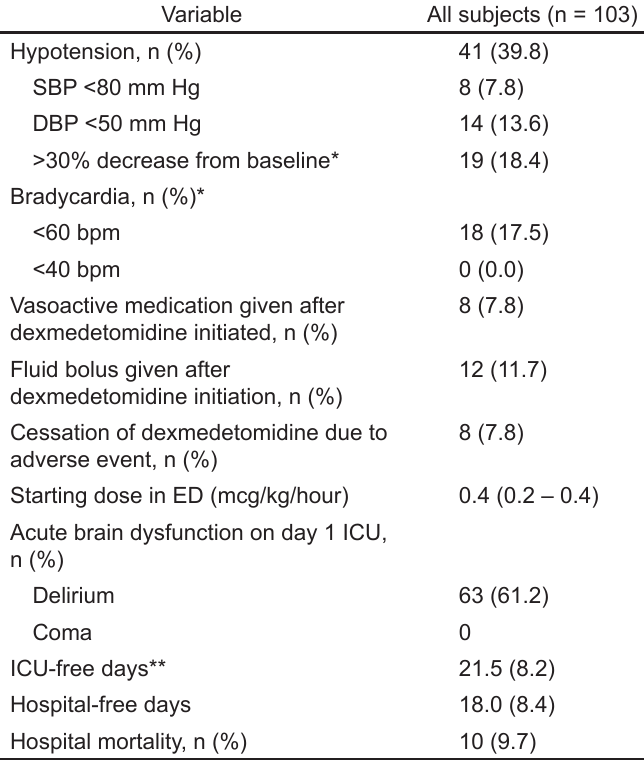
Table 3. Adverse events and clinical outcomes.